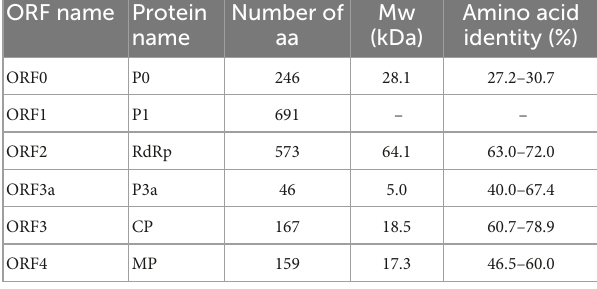
TABLE 4 The information on LaPV-1 encoding